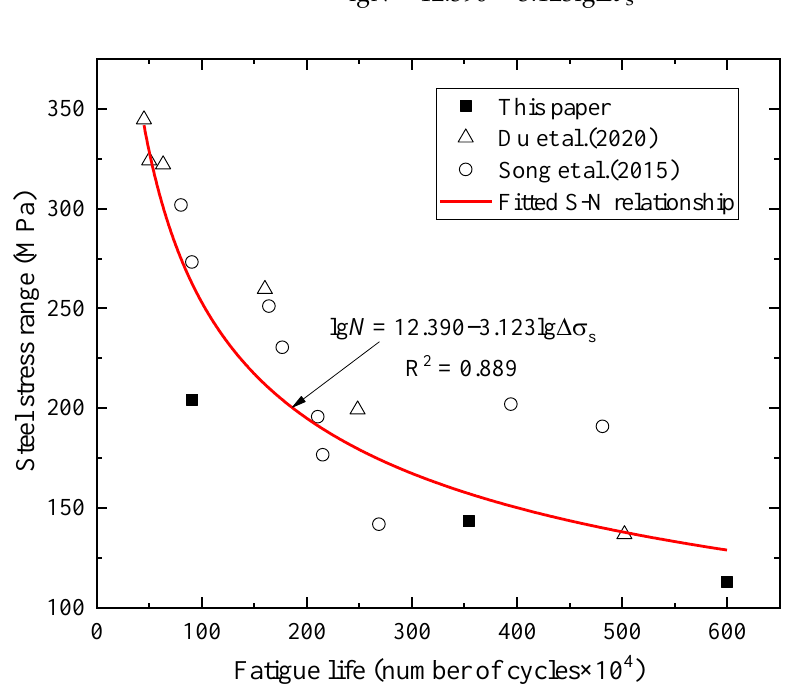
Figure 13. The relationship between the stress amplitude of the steel bar and the number of fatigue failure cycles [21,27].